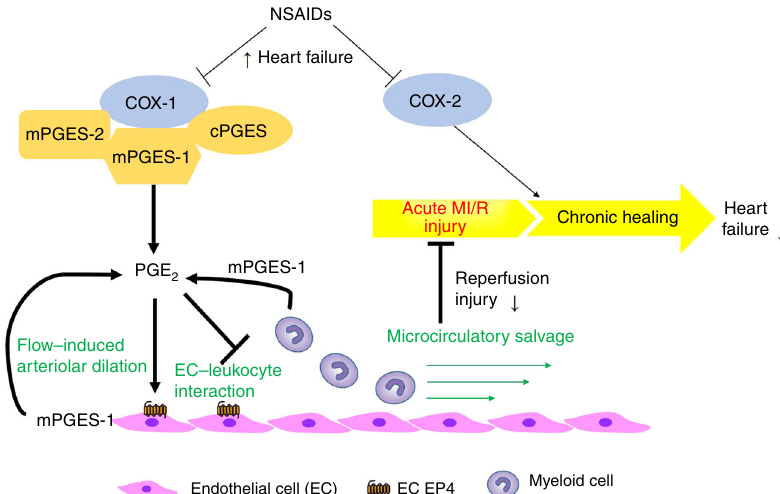
Fig. 8 Schematic illustration of the role of mPGES-1 and EC EP4 in MI/R. Use of NSAIDs is associated with heart failure. In MI/R related heart failure, the COX pathway protects against development of heart failure through acute protection mainly via COX-1/mPGES-1, as shown in the present study (key components/steps highlighted in bold text), and through chronic healing mainly via COX-2, as shown in previous studies. COX-1, the constitutive COX isoform and mPGES-1 contribute substantially to PGE 2 biosynthesis and limit acute MI/R injury. mPGES-1, the major source of PGE 2 in endothelial cells and myeloid cells, plays a pivotal role in mediating fl ow-induced arteriolar dilation and in limiting EC – leukocyte interactions, under I/R. By doing so, mPGES-1 preserves the microcirculation and further constrains MI/R injury. These bene fi cial effects are mediated in part via endothelial EP4 receptors. → denotes ‘ prostanoid production ’ or ‘ positive regulation ’ ; ┤ denotes ‘ inhibition ’ ; the thick lines highlight the key fi ndings of this study. cPGES: cytosolic PGE